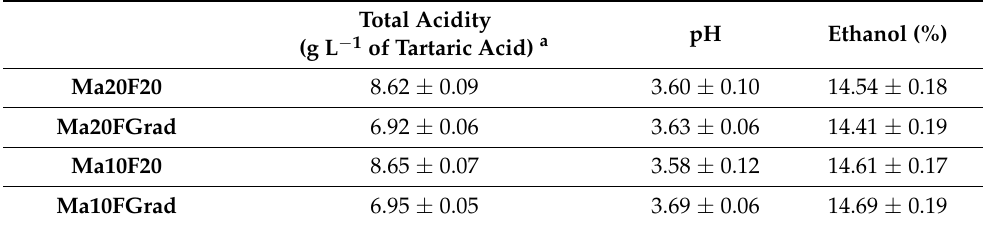
Table 1. Average acidity, pH level and ethanol content of the wines produced under different winemaking